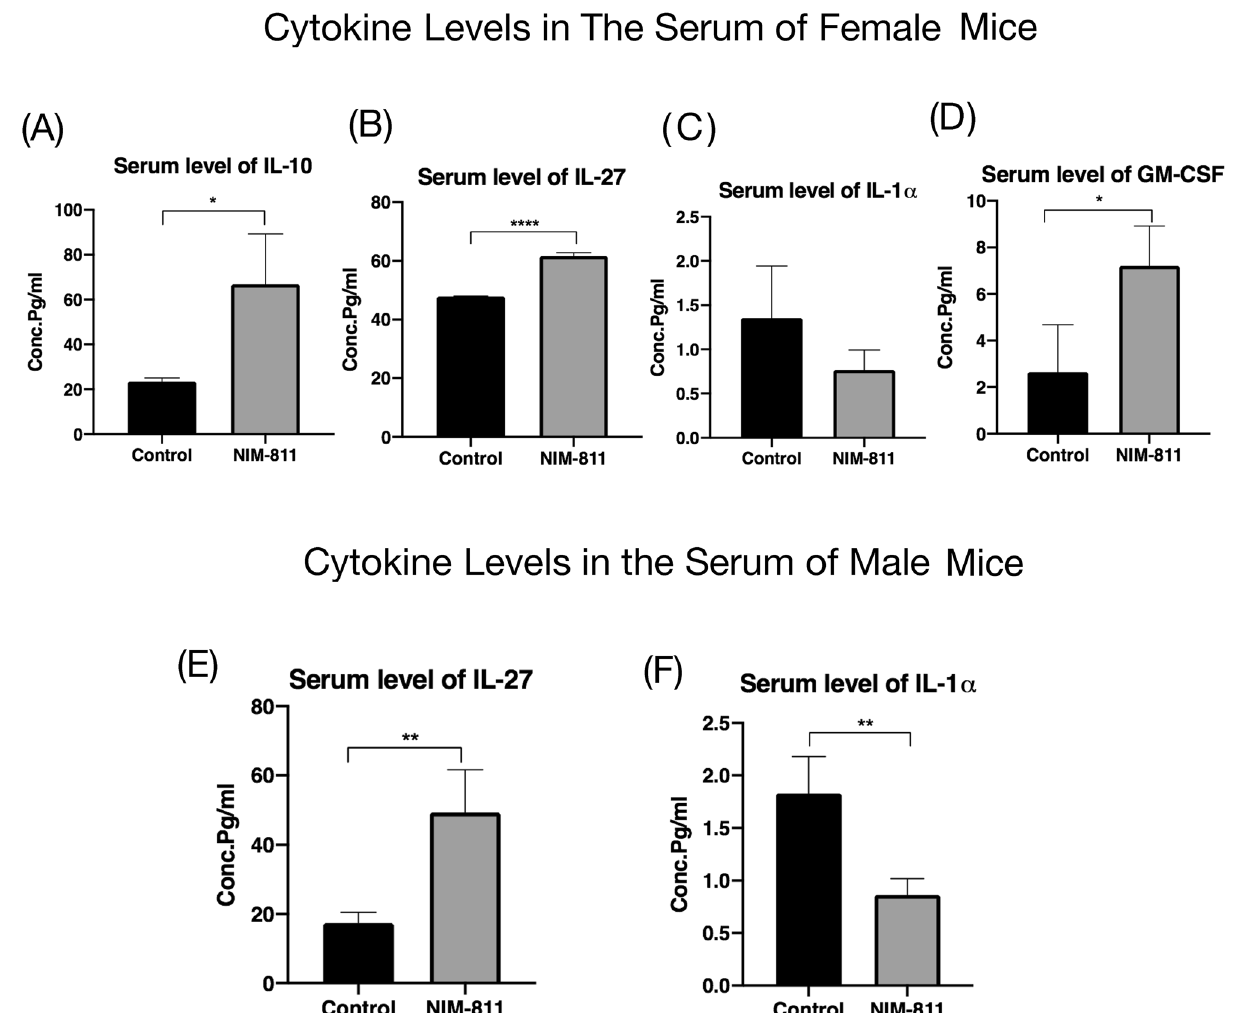
Figure 6. Serum cytokine levels in female and male mice after hindlimb ischemia–reperfusion and treatment with NIM-811. ( A – C ) Serum IL-10, IL-27 and GM-CSF levels increased significantly in the serum of female mice treated with NIM-811 compared to control croup. ( D ) Serum IL-α level decreased significantly in the serum of female mice treated with NIM-811 compared to control group. ( E ) Serum IL-27 level increased significantly in the serum of male mice treated with NIM-811 compared to control croup. ( F ) Serum IL-α level reduced in the serum of male mice treated with NIM-811 compared to control croup. *P < 0.05, **P < 0.01 and ***P <